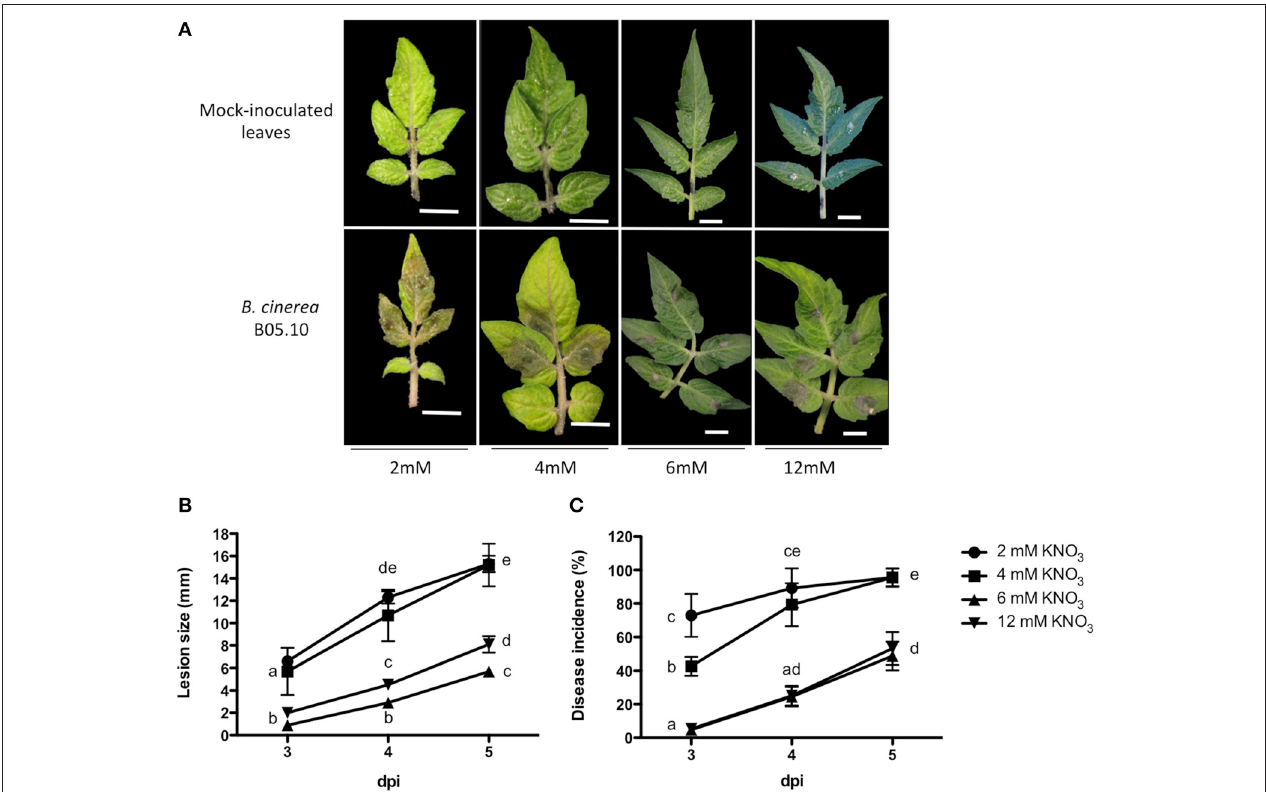
FIGURE 1 | Tomato leaves susceptibility to B. cinerea in plants grown under different nitrate concentrations. (A) Representative inoculated leaves (3 dpi) for each nitrate condition used throughout this study. (B) Lesion size, measured as diameter of expanding lesions, for the indicated nitrate concentrations. (C) Disease incidence (percentage of leaf area with disease symptoms). Different letters indicate significant differences among treatments at a given time point ( p ≤ 0.05 ; error bars indicate SEM; n = 6 ).